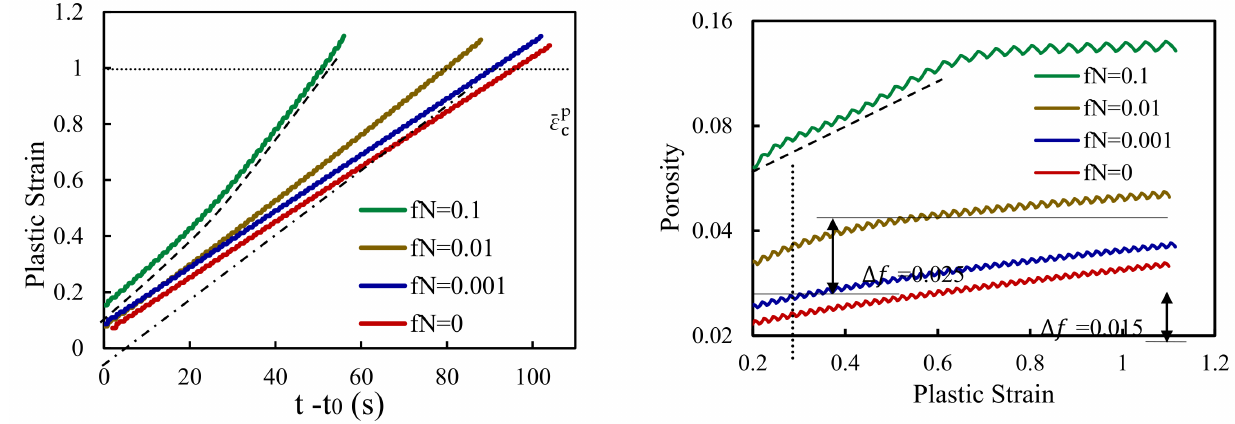
Figure 14. ( a ) Evolution of plastic strain for the same entire propagation depending on the f N 0.015. With f N = 0 value. ( b ) Evolution of porosity in terms of plastic strain for the different values of f N , porosity is in logarithmic